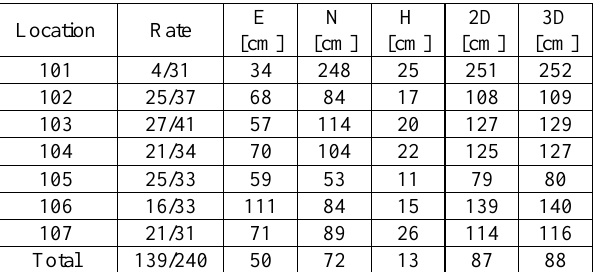
Table 3. Standard deviations of projection centres per